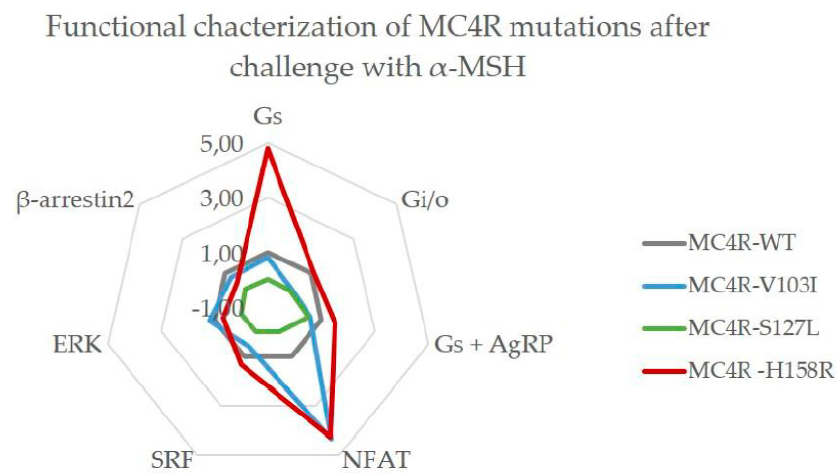
Figure 4. MC4R mutations V103I and H158R have a strong bias towards NFAT via PLC activation after challenge with α -MSH. As a reference, MC4R WT (gray) is plotted at a value of 1.0. The V103I mutant (blue) acted similarly to the WT in most pathways tested but had increased activity in the G q/11 pathway, and a decrease in G i/o coupling. MC4R S127L (green) lost function in all tested pathways but responded to the antagonist Agouti related peptide (AgRP) in a similar manner to the WT. H158R (red) was a gain-of-function mutation for both the G S and G q/11 pathway. Each value is based on EC 50 and curves for each pathway from three to seven independent experiments performed in triplicates.